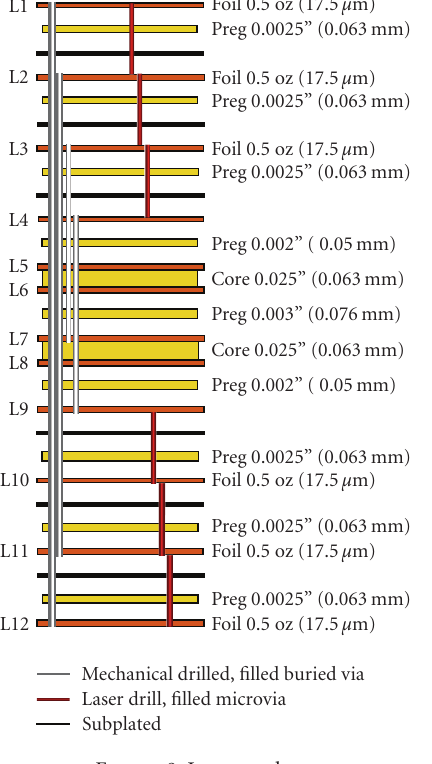
Figure 8: Layer stackup.